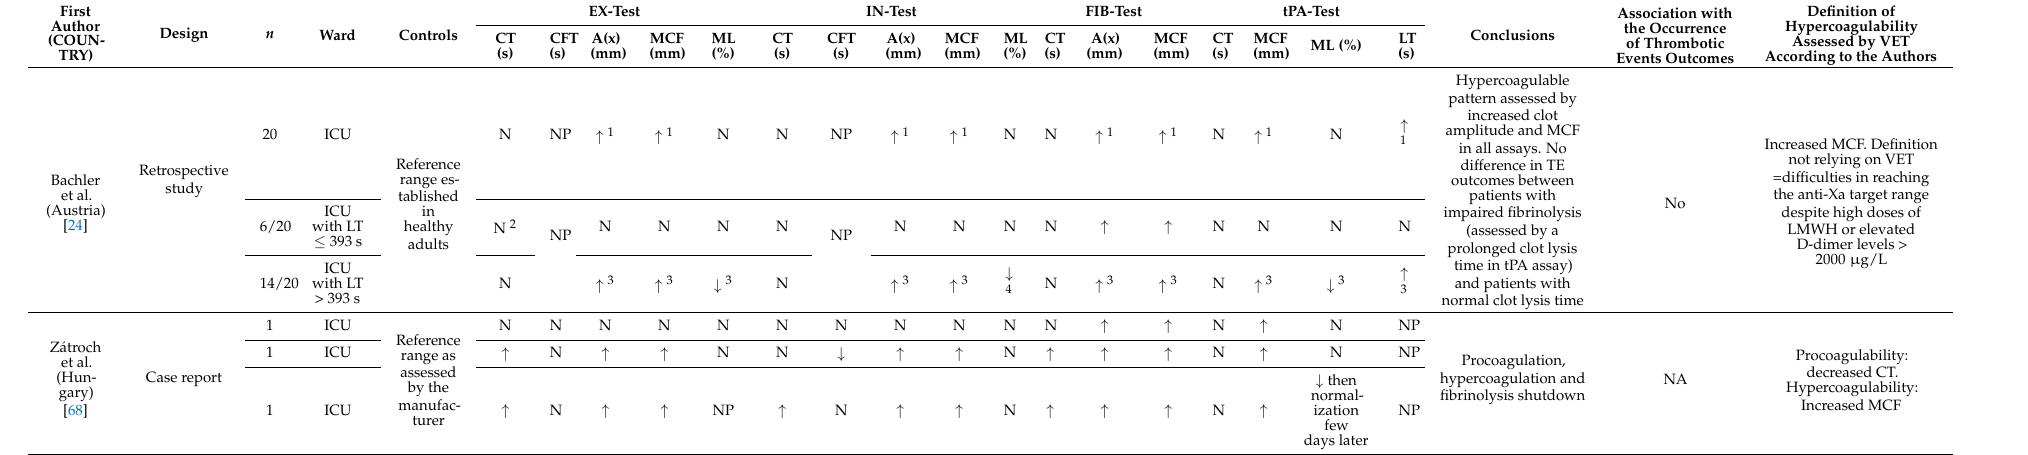
Table 10. Main findings of studies reporting ClotPro